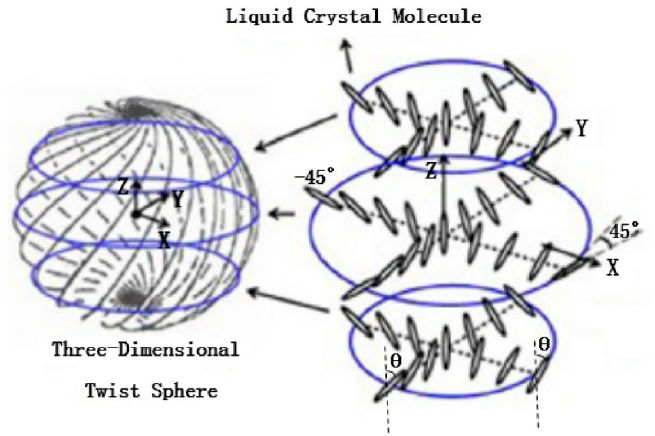
Figure 11. The model of the three-dimensional twist sphere structure in the sphere phase [71]. Reprinted with permission from Ref. [71]. 2019 MDPI.